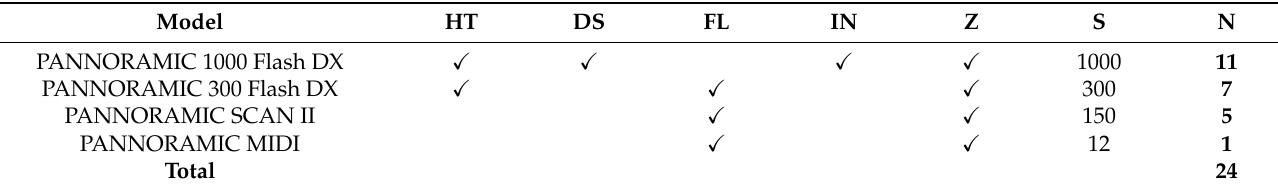
Table 2. Scanner deployment and capabilities